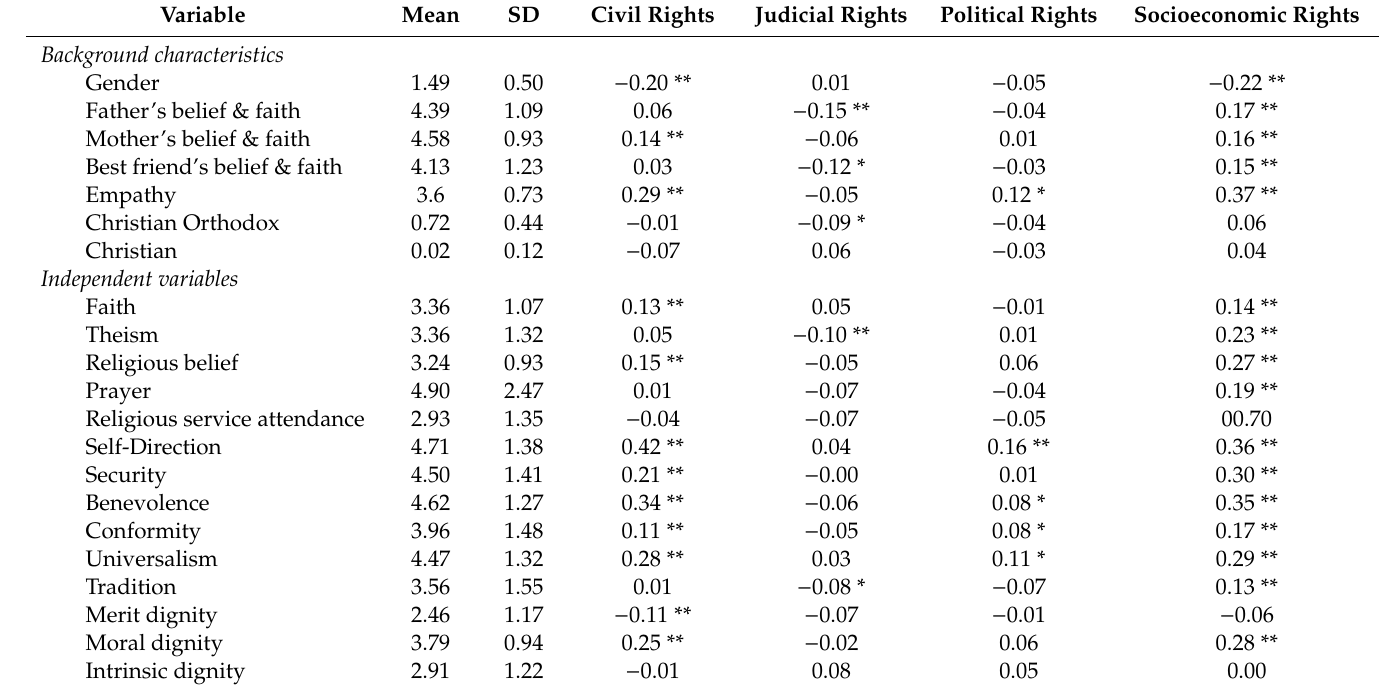
Table 10. Correlations (Pearson’s r ) between human rights, independent and control